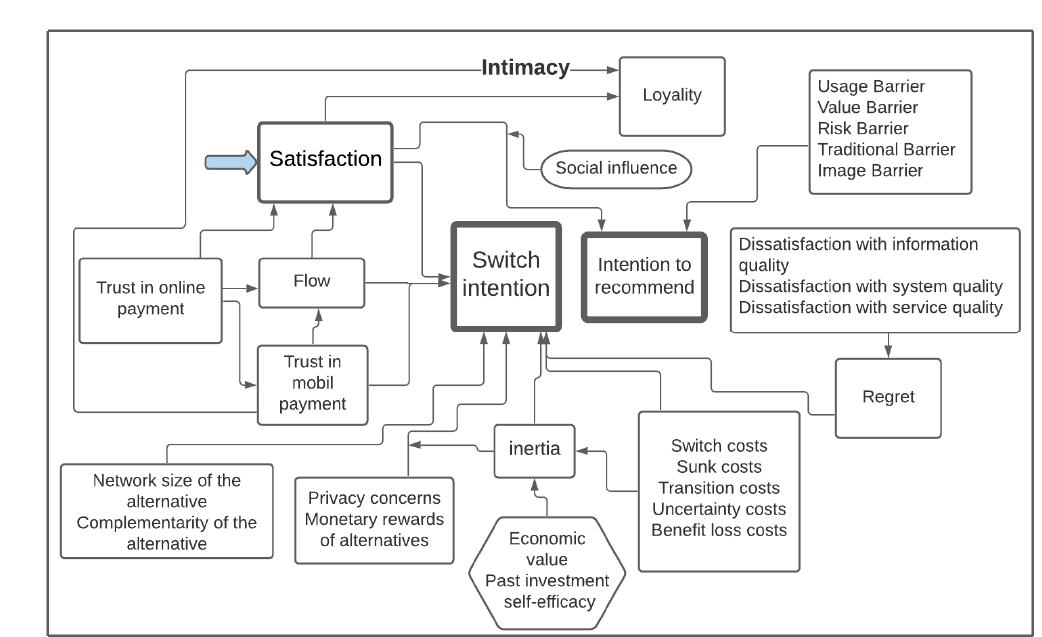
Figure 8. The switch model of electronic payment.